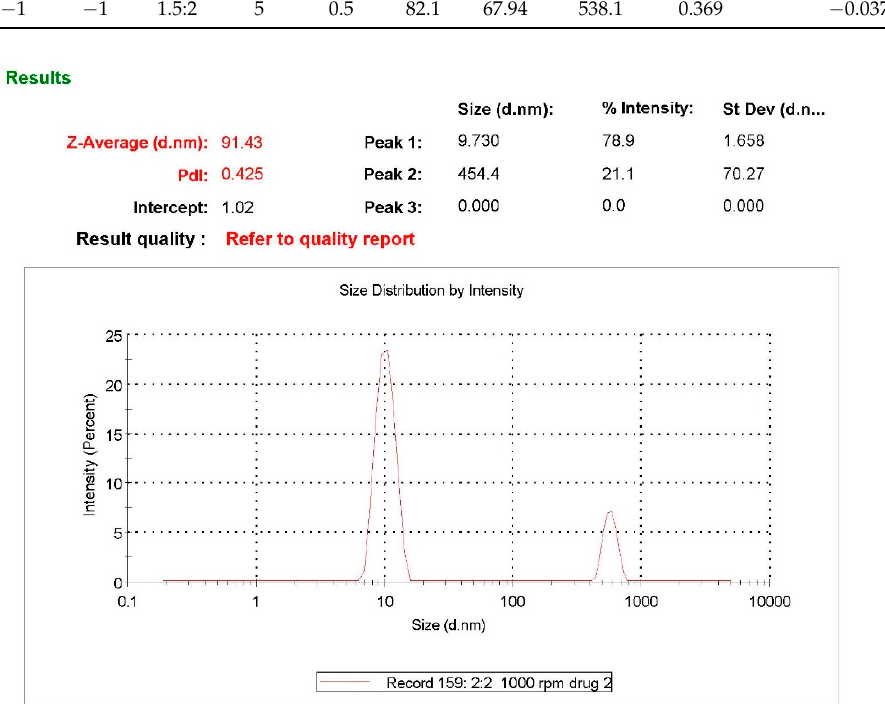
Figure 3. Zeta potential analysis of optimized hesperidin-loaded lipid polymer hybrid nanoparticles (HLPHNs).